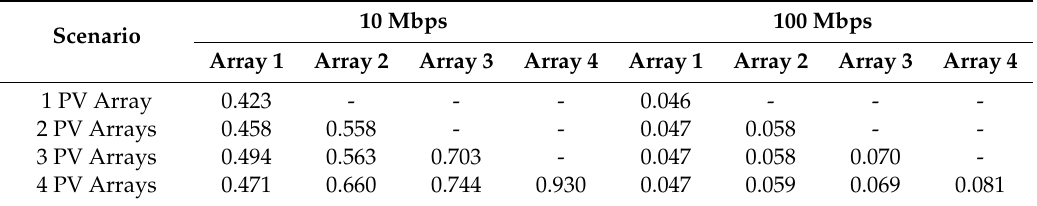
Figure 6. OPNET model for communication network of the PV power plant.